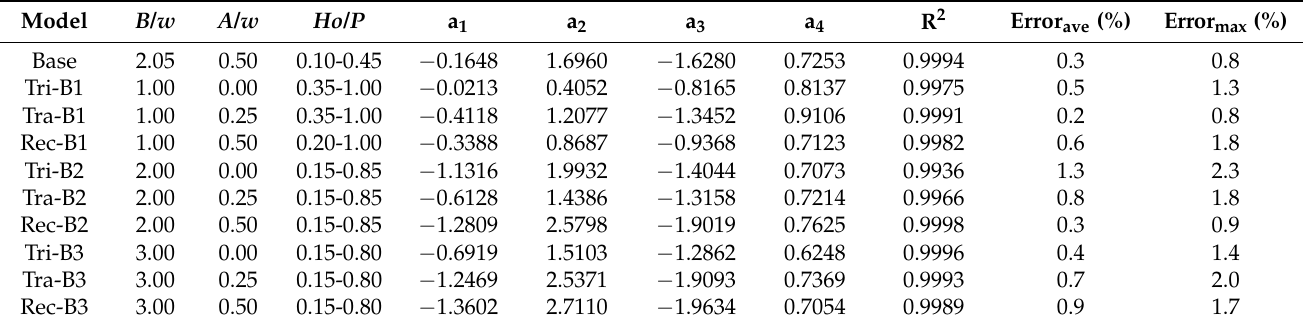
Figure 21. Relative efficiency of PKWs versus: ( a ) H o / P and A / w (subscripts of B 3 and B 1 respectively refer to B / w = 3 and 1), respectively;); ( b ) H o / P and B / w (subscripts of Tri, Tra, and Rec respectively refer to A / w = 0, 0.25, and 0.5, respectively). Table 4. Volume of PKW bodies ( C ) in the experimental scale with three keys. B/w